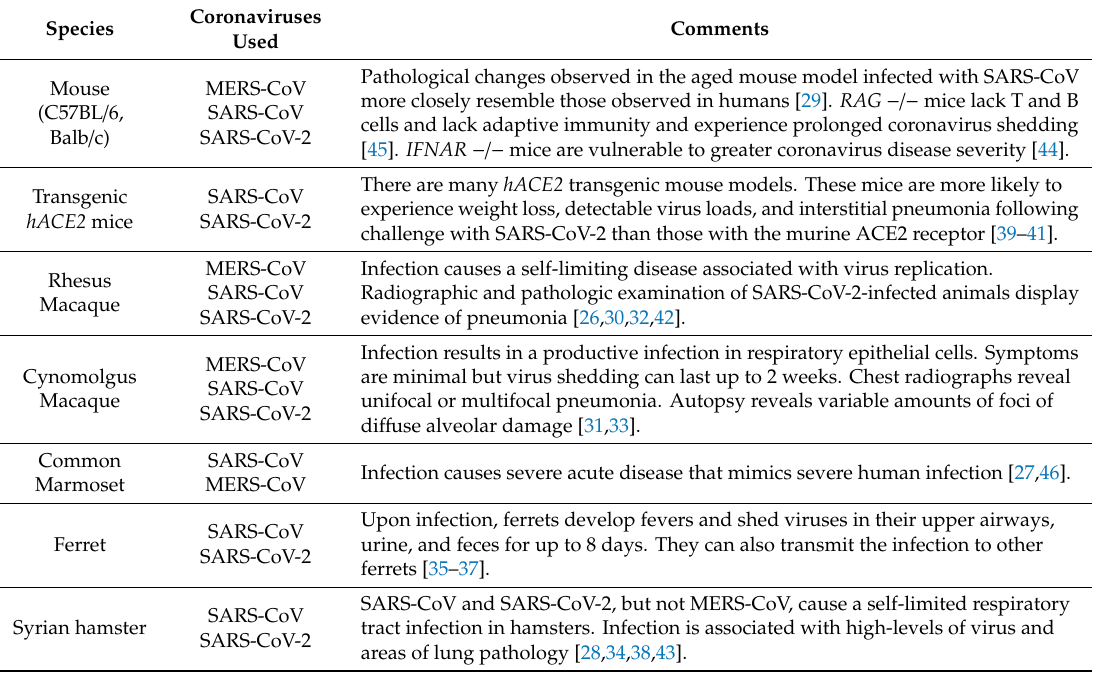
Table 2. Animal models for pandemic coronavirus antiviral